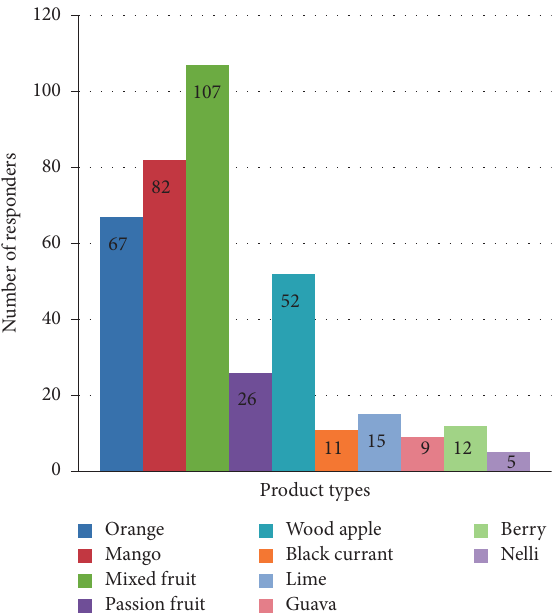
Figure 4: Distribution of preference of fruit nectars.